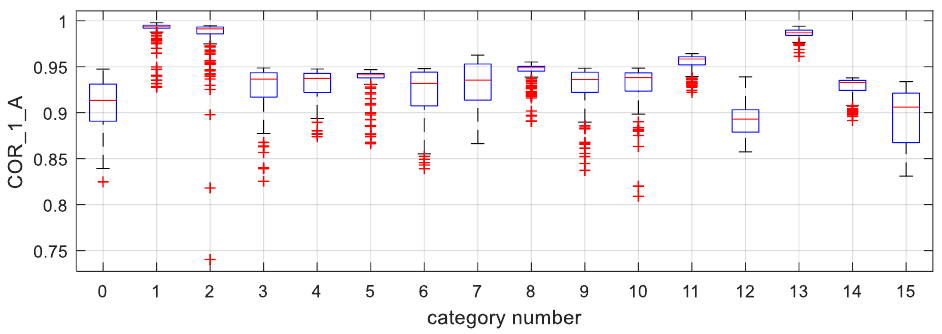
Figure 24. Box plot of feature COR_1_A.